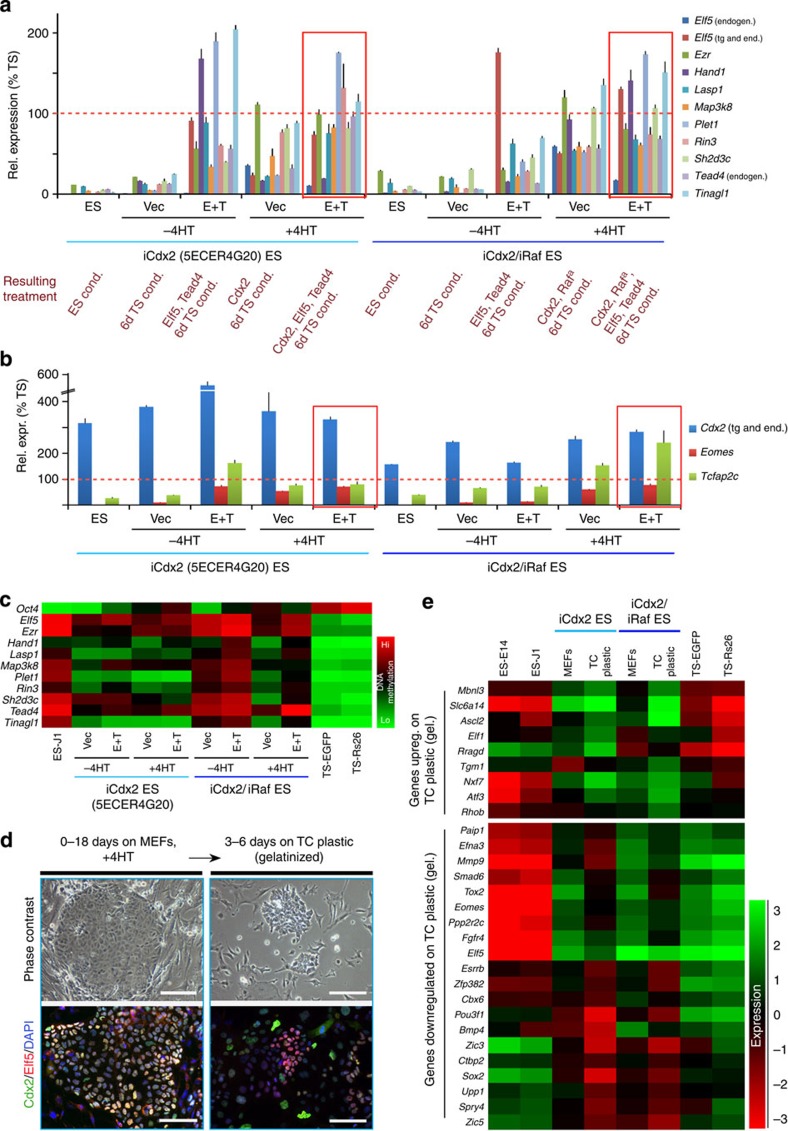
The three core TS cell transcription factors Cdx2, Elf5 and Tead4 are insufficient to complete reprogramming to induce a stable TS cell phenotype in bulk culture.(a) iCdx2 cells, shown previously to be capable of placental contribution18, and iCdx2/iRaf cells were transfected with an Elf5-2A-Tead4-2A-HygroR (E+T) or HygroR-only control (vec) expression construct, subjected to the trans-differentiation protocol for 6 days on antibiotic-resistant MEFs, FACS-purified from MEFs and assessed for gatekeeper gene expression levels by RT–qPCR. Details of overexpressed genes resulting from the various conditions are given in red. Elf5 and Tead4 expression, in conjunction with Cdx2 activation, improves the activation of some of the remaining gatekeeper genes. Values are of three biological replicates and expressed as percent of TS cell expression levels combined of the two independent TS cell lines (mean±s.e.m.). (b) Activation of TS cell transcription factors in the same cells as in (a). Hyperactivation of Tcfap2c and Hand1 (in a) indicate onset of terminal trophoblast differentiation. Values expressed as in a. (c) Dynamics of methylation reprogramming of these cells at the ES-DMRs identified by meDIP-seq and assessed by Sequenom analysis as in Fig. 4c. (d) Assessment of phenotypic stability of reprogrammed TSL (iCdx2) cells. Upon removal of the MEF layer, the tight epithelial colony shape that is characteristic of bona fide TS cells was rapidly lost, and cells failed to maintain the co-expression of Cdx2 and Elf5 that is required to preserve the proliferative, self-renewing TS cell state, and instead started to differentiate. Scale bars: 200 μm (phase contrast), 100 μm (immunofluorescence). (e) RNA-seq analysis of iCdx2 (5ECER4G20) and iCdx2/iRaf ES cells grown for 5 days on MEFs, and then replated for 3 days on gelatinized TC plastic. Note the instability of gene expression, and specifically the downregulation of critical TS cell genes such as Eomes, Elf5, Esrrb and Sox2 upon transfer of reprogrammed TSL cells from MEFs onto TC plastic.